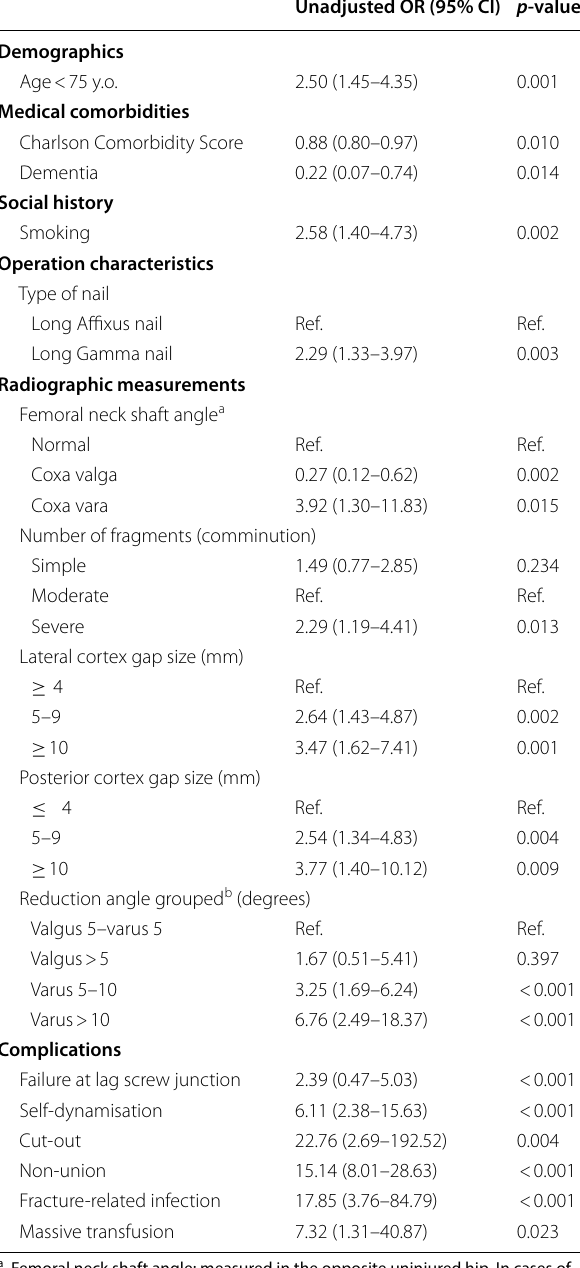
Table 2 Unadjusted associations with re-operation Table 3 Multivariate models demonstrating associations with re-operation following a subtrochanteric